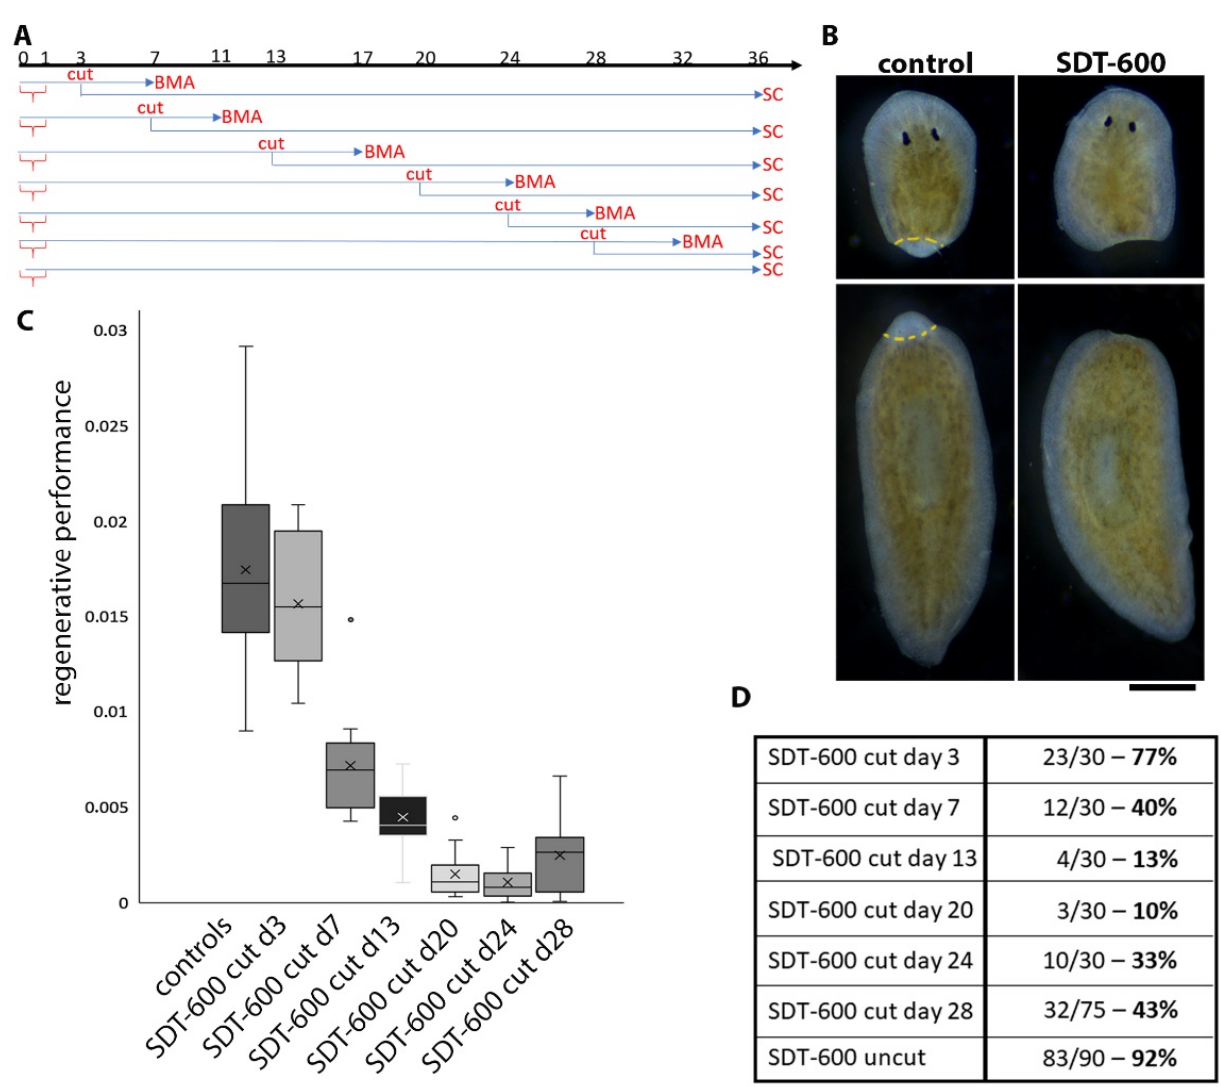
Figure 6. Analysis of regenerative performance and survival rate. ( A ) Graph depicting the experimental setup. Red brackets indicate 5FU treatment. BMA = blastema morphometric analysis; SC = survival count. ( B ) Representative images of head and tail pieces cut 13 days after 5FU treatment and fixed for morphometric analysis of blastema size at the fourth day of regeneration. ( C ) Box plot showing the regenerative performance (blastema area/regenerating fragment area) of animals cut according to the experimental plan described in ( A ); horizontal lines in the box plot indicate the median values; X = mean value. ( D ) Table showing the percentage of alive animals at day 36 from treatment. Scale bar corresponds to 500 μm.